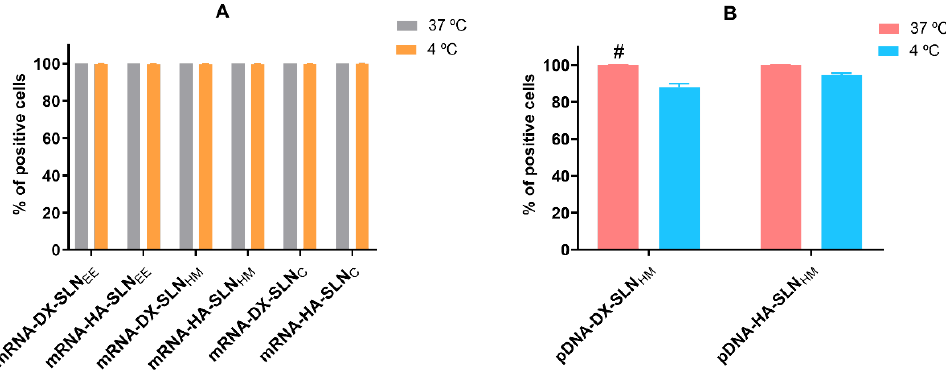
Figure 3. Cellular uptake of vectors using Nile-Red labelled SLNs in HCE-2 cells at 37 ◦ C and 4 ◦ C analyzed by flow cytometry. Percentage of positive cells correspond to the cells which have uptaken the vectors labeled with Nile Red over the total cells. Data are expressed as mean ± standard deviation; n = 3. ( A ) Percentage of Nile Red positive HCE-2 cells 2 h after the addition of mRNA-based vectors. ( B ) Percentage of Nile Red positive HCE-2 cells 2 h after the addition of pDNA-based vectors. # p < 0.05 with respect to the same vector at 4 ◦ C. DX: dextran; HA: hyaluronic acid; SLN EE : solid lipid nanoparticle prepared by emulsification-evaporation method. SLN HM : solid lipid nanoparticle prepared by hot-melt emulsification method. SLN C : solid lipid nanoparticle prepared by coacervation method.